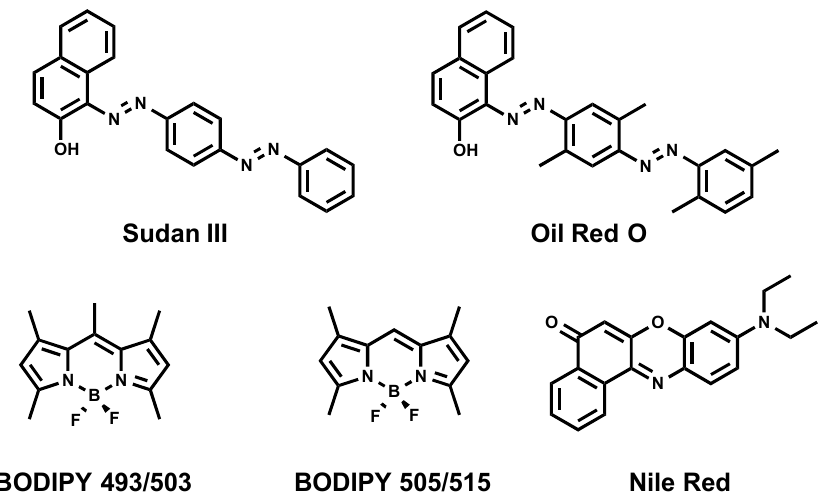
Figure 2. Chemical structures of commonly used fluorescent dyes.